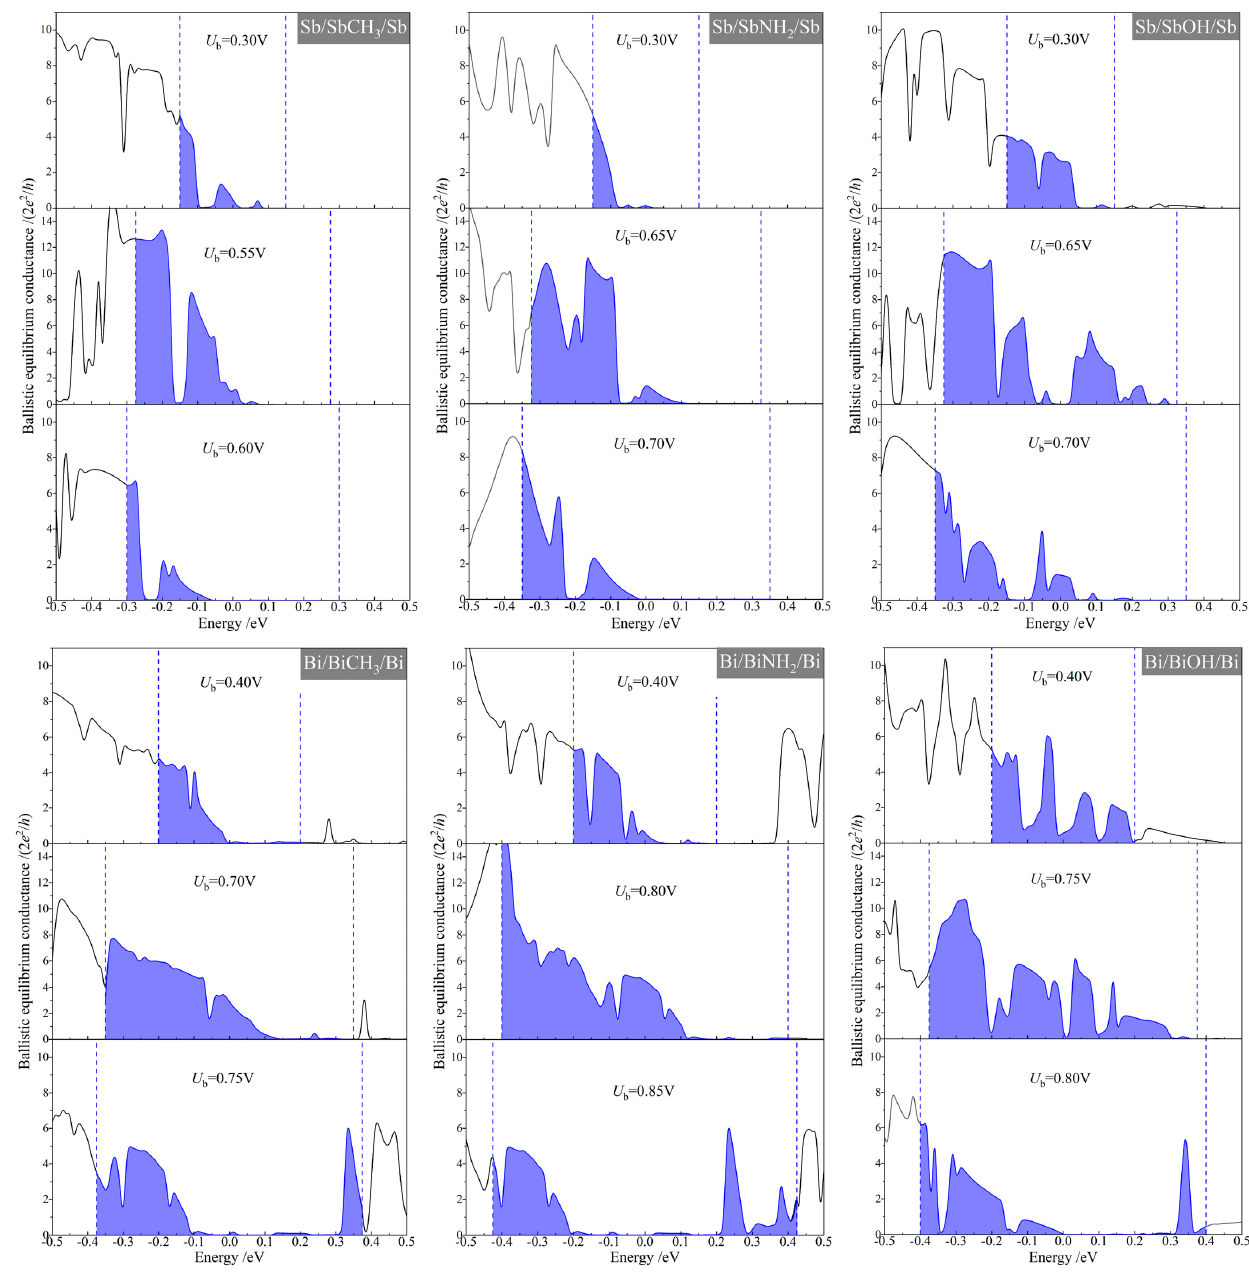
Figure 6. Electron transmission spectra of resonant tunneling transistors modeled by Sb/SbXH n /Sb and Bi/BiXH n /Bi nanoribbon double-heterostructures.